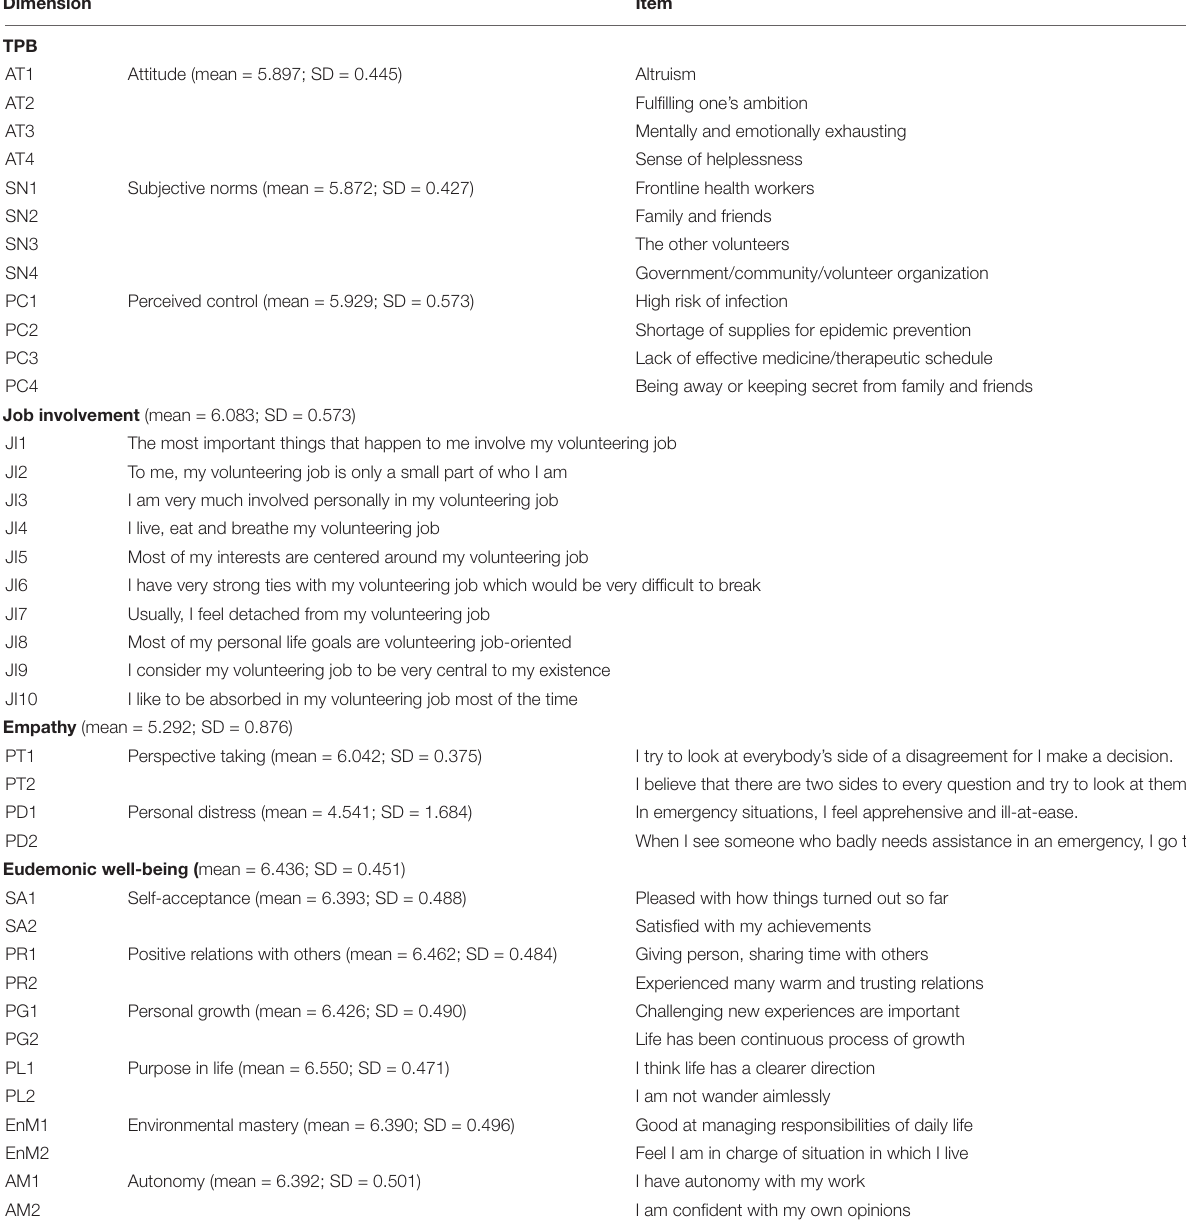
TABLE 4 | Questionnaire items, reliability, validity, mean scores, and standard deviations of study 2. Dimension